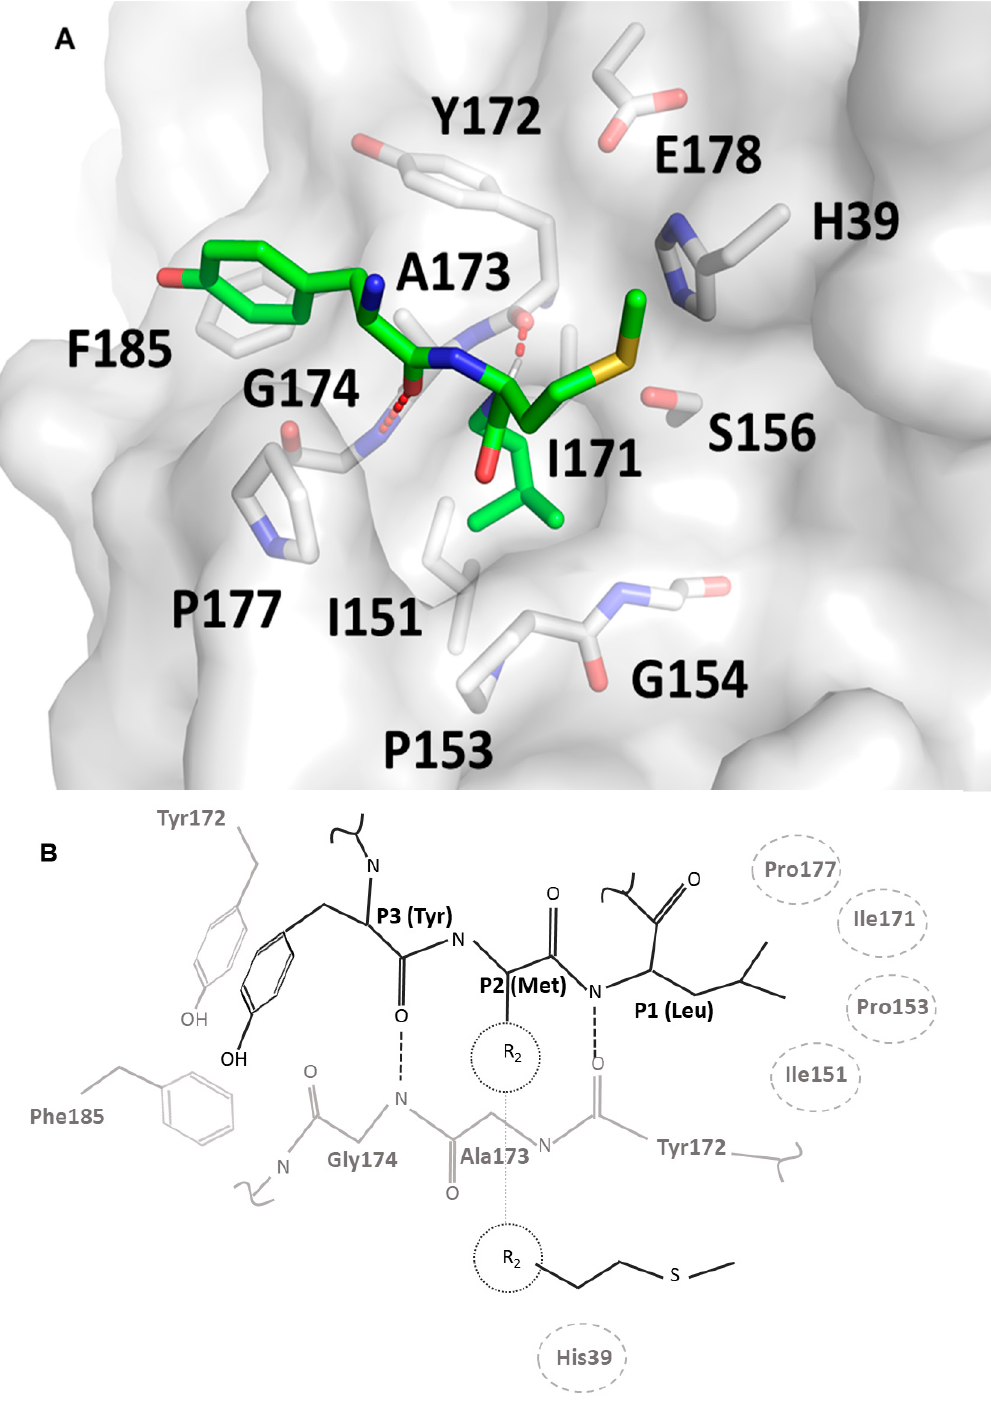
Figure 3. Model of consensus substrate recognition by SplF protease. ( A ) The overall orientation of the substrate (green) backbone was modeled based on the crystal structure of substrate mimetic inhibitors in complex with trypsin. The positions of the sidechains were adjusted by energy minimization. SplF (gray) residues involved in active site formation are highlighted in the stick model and labeled. ( B ) Schematic representation of substrate (black line)–enzyme (gray line) interaction. Hydrogen bonds are shown as dashed lines. Ring stacking is indicated. The enzyme residues involved in hydrophobic interaction are indicated by dashed